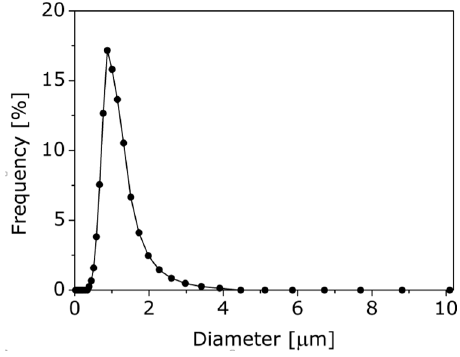
Figure 1. Obtained polymer particle size distribution.